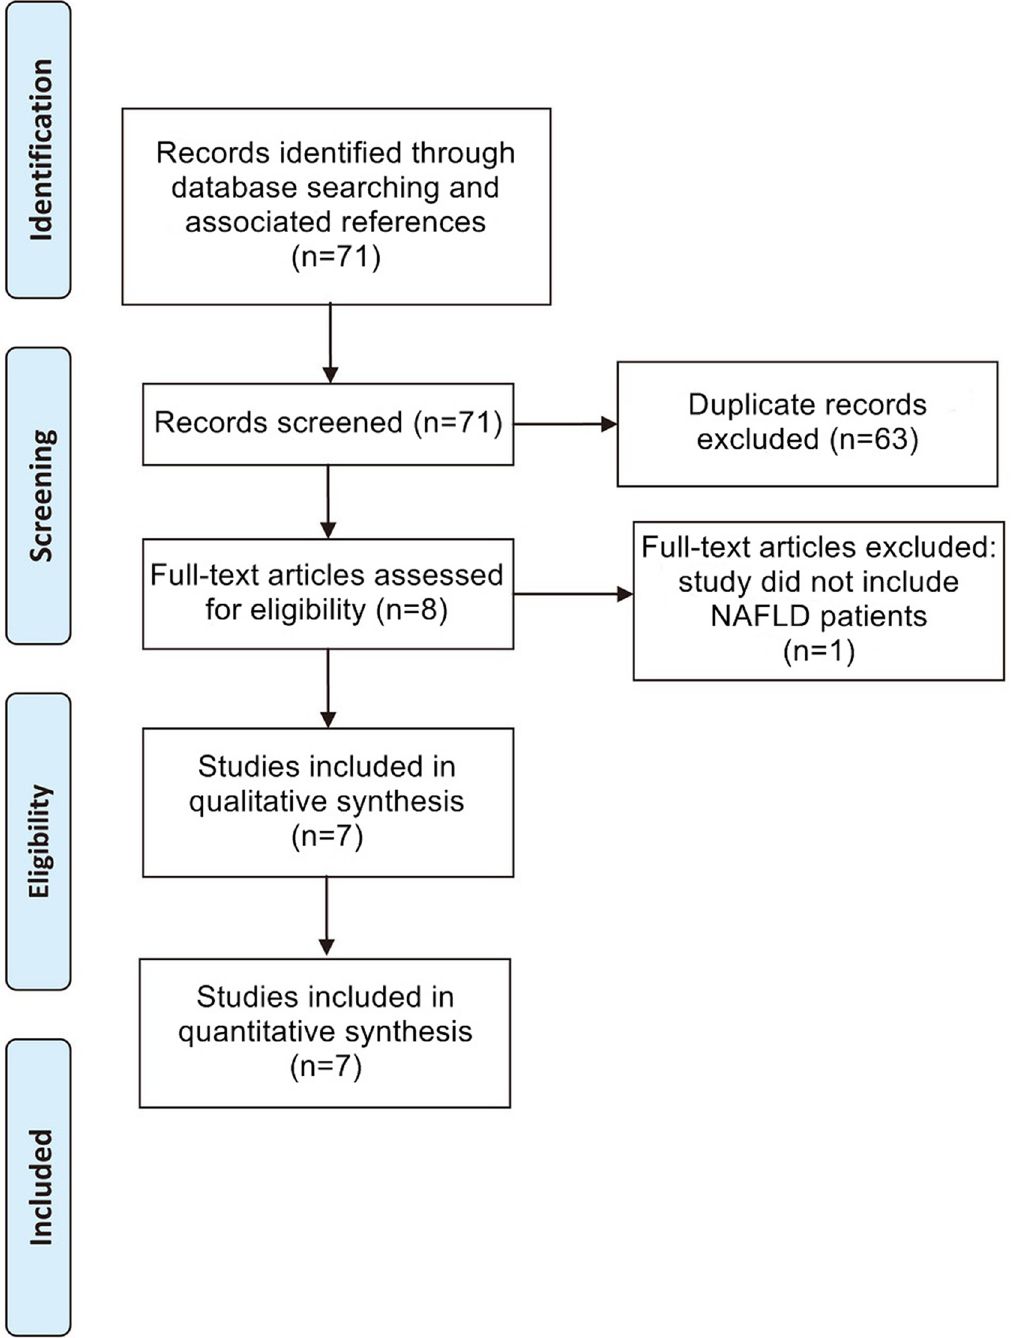
Fig 1. Flowchart of Study Selection. Flowchart depicting the study selection process for this systematic review and meta-analysis.